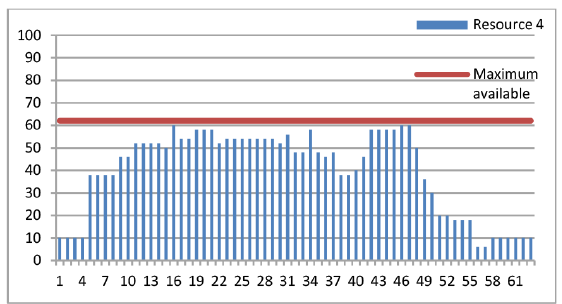
Figure 51. Daily usage of resource 3 throughout the calendar of the project (before using the method)-Experiment 3